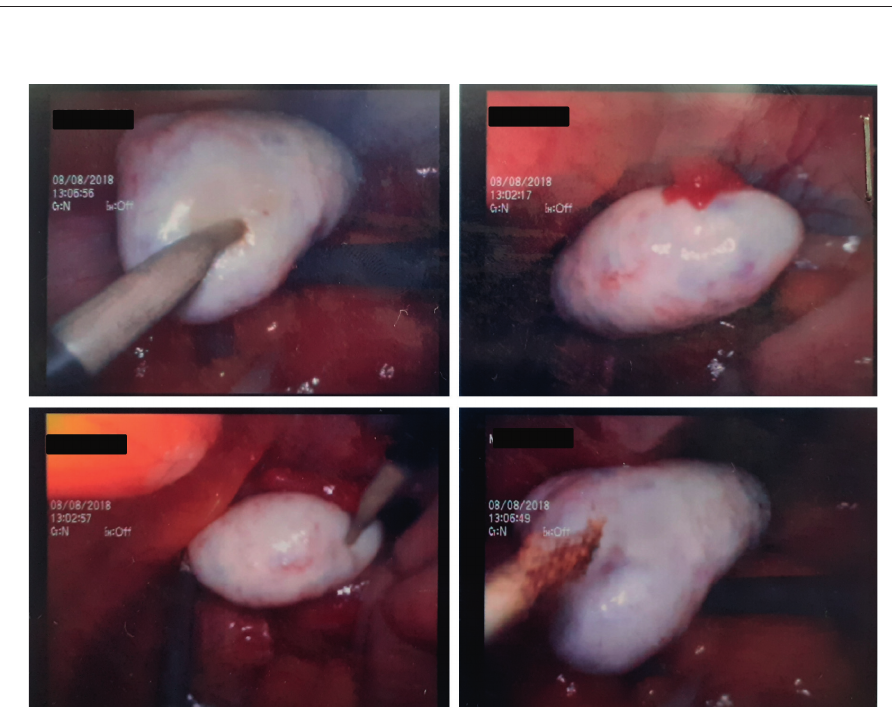
Figure 4: Enlarged bilateral ovaries with typical polycystic